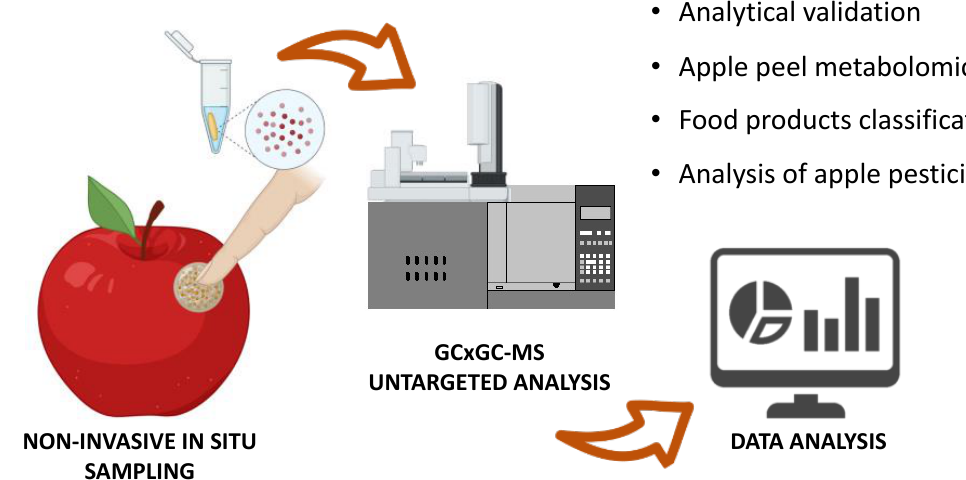
Figure 1. Experimental workflow of the methodology. Small molecules are sampled from the apple surface through a functionalized strip. The molecules are then eluted from the strip and analyzed using an untargeted metabolomic approach with a bidimensional gas chromatography system coupled with mass spectrometry. Markers of apple varieties are identified using both monovariate and multivariate statistical analysis. Finally, using classification algorithms, the apple varieties can be recognized. The analysis of pesticides from apple peel can also be performed.